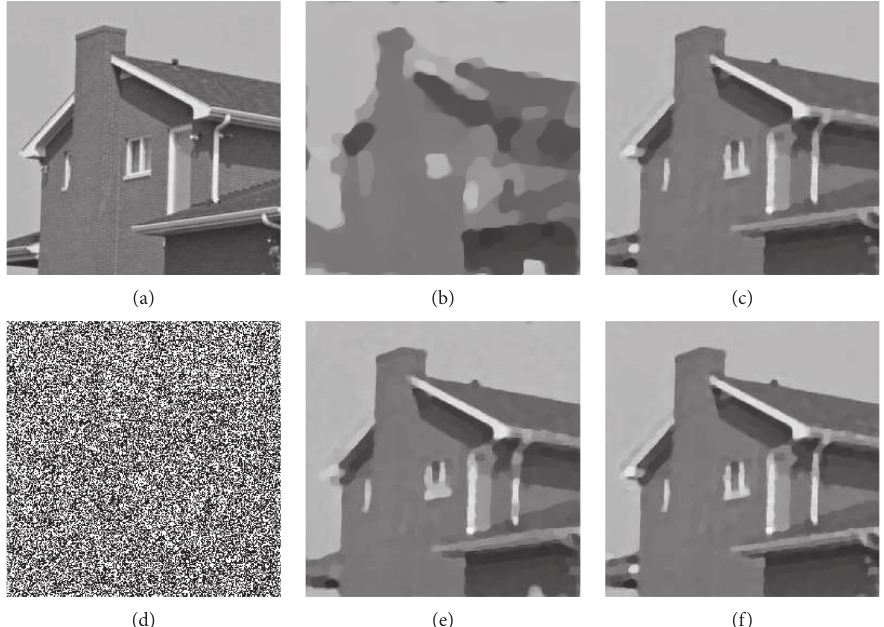
Figure 7: The recovery results (House 256) by Average blur with 90% SP noise. (a) Original. (b) TVL1, PSNR � 18.9538. (c) TVSCAD, PSNR � 26.9624. (d) Average blur (lev � 0.9). (e) TVLog, PSNR � 25.0969. (f) LogTVSCAD, PSNR �